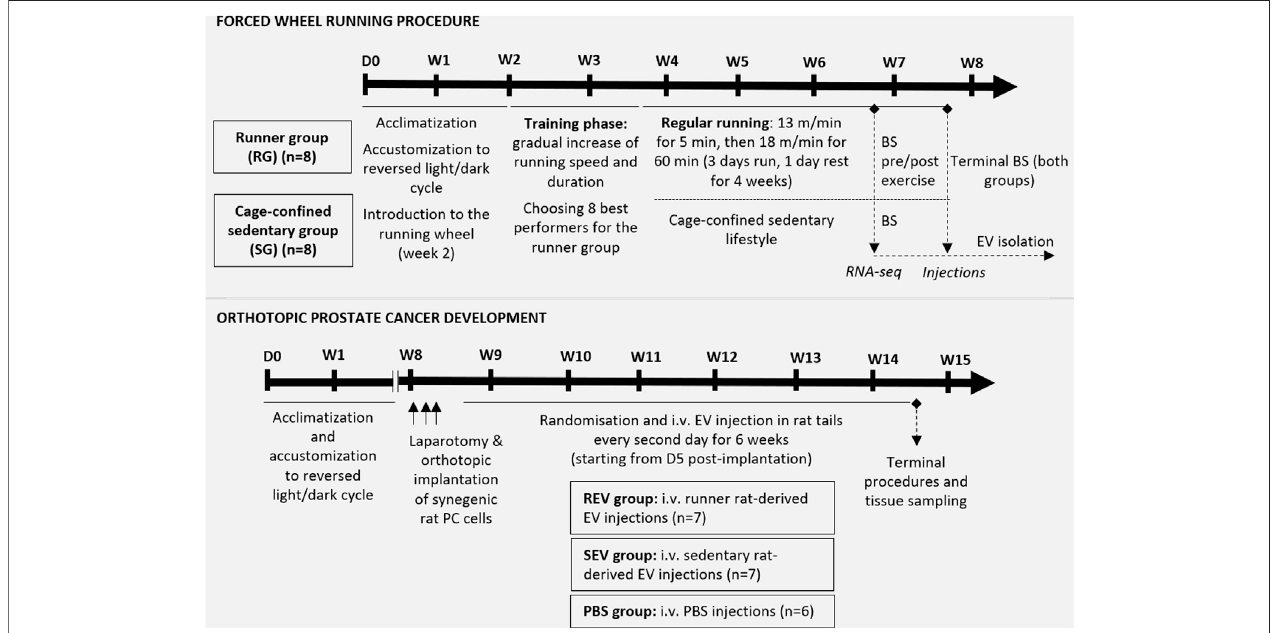
FIGURE 1 | Schematic overview of the in vivo study design. The upper panel represents the steps of the forced wheel running procedure — in total, sixteen 7 w/o male F344 rats underwent a 2-weeks acclimatization period. During the second week, rats were introduced to the running wheel, which was followed by a 12-days trainingphaseforallexperimentalanimals.Duringthetrainingphase,8bestperformerswerechosenfortherunnergroupwhiletheremaining8ratswereassignedtothe cage-con fi ned sedentary group. The running exercise phase lasted for 5 weeks in total, including 4 weeks of regular running in a setting described in the fi gure. After 4 weeks of exercise, blood samples were taken before and shortly after 1 h running from the runner group and a single blood sample from the control animals for further plasma EV analyses. At the endpoint, total blood sample was taken via cardiac puncture and used for plasma EV isolation. The lower panel shows the steps of in vivo evaluation ofthe effect ofEVs (isolated from theendpointplasmasamples)on orthotopic PCdevelopmentin syngeneicmale F344 rats.Brie fl y,anesthetized12w/o male F344 rats were subjected to a laparotomic incision to enable orthotopic implantation of 5 × 10 6 PLS10 rat prostate cancer cells into the ventral prostate. After strati fi ed randomization, the animals were divided into 3 groups and, starting from day 5 post-implantation, rats from all 3 groups received i.v. injection of EVs or PBS as shown. After 6 weeks of injections, animals were sacri fi ced, and tissues of interest were collected. BS, blood sampling; D, day; i.v., intravenous; W,